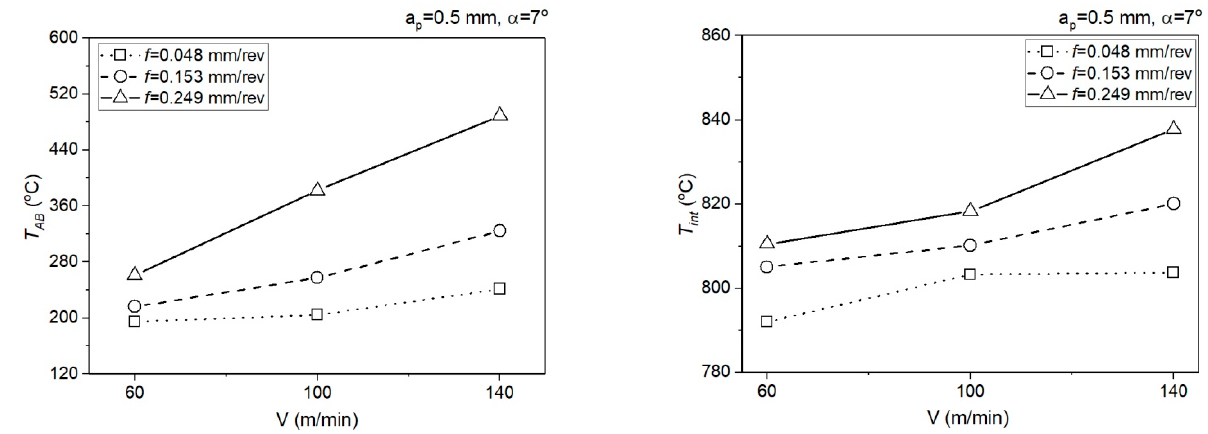
Figure 10. Impact of the cutting data on the mean temperature in the PSZ and SSZ, a p = 0.5 mm, α = 7°. Figure 11 presents the relationship of analytically determined mean temperature in the PSZ ( T AB ) and SSZ ( T int ) for a p = 1.77 mm.